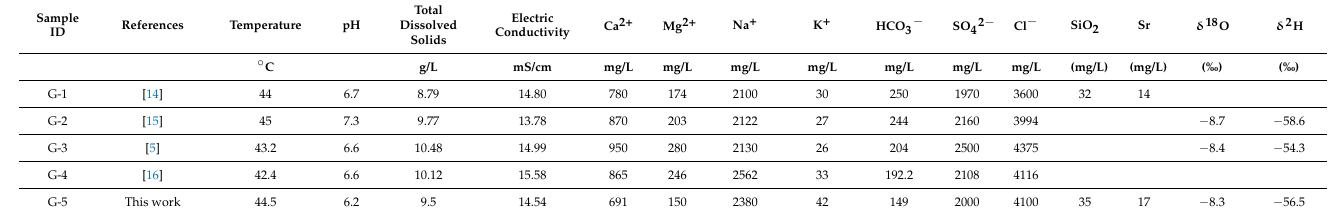
Table 1. Physico-chemical results of the thermal waters of Goutitir along 19 years.